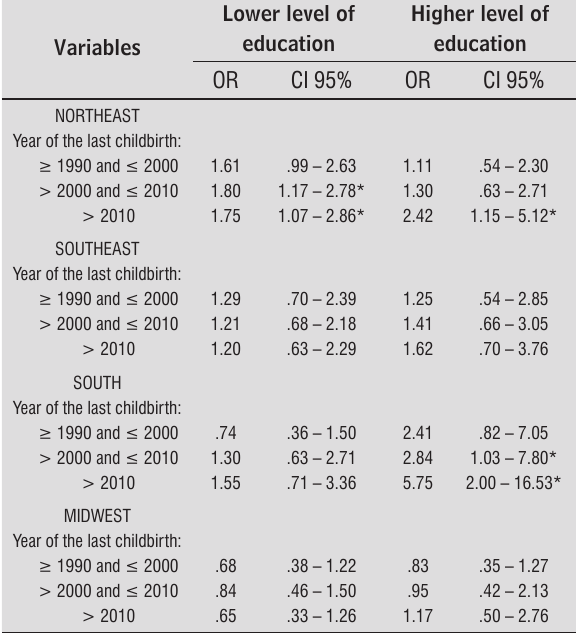
Odds Confidence Ratio Interval 95